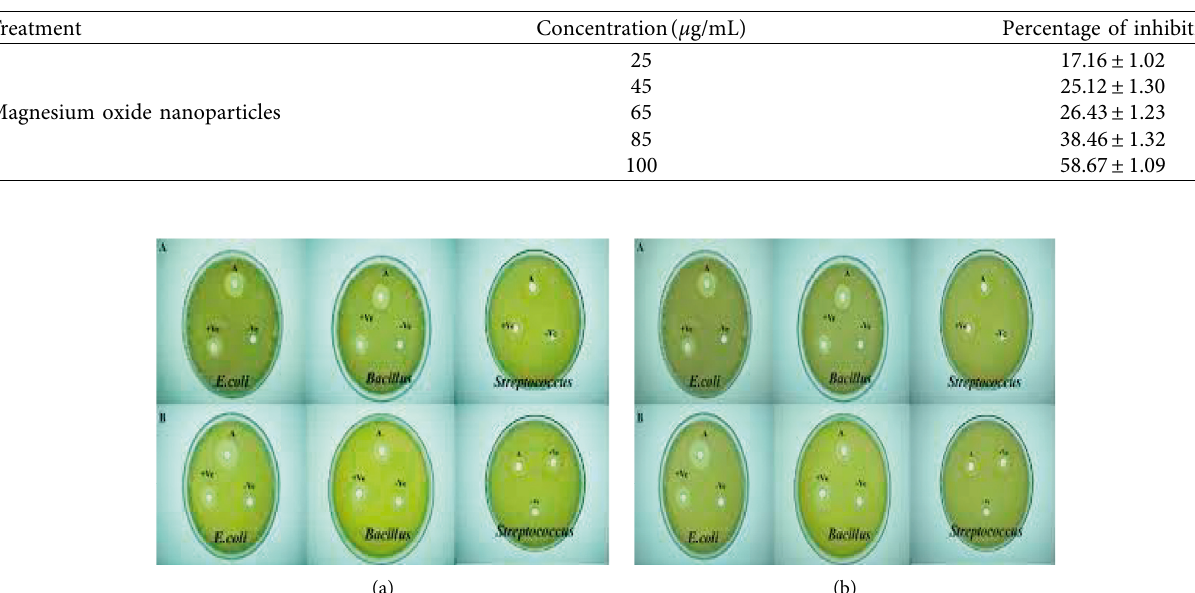
Table 2: Bacterial activities of biosynthesized MgO nanoparticles.